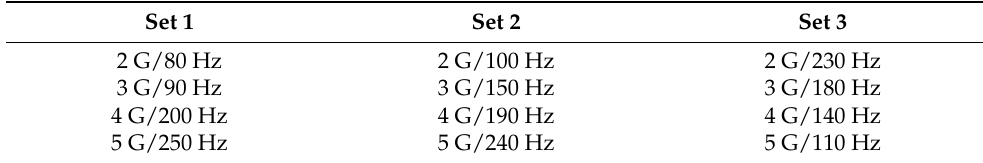
Table 1. Haptic signal sets in the experiment.